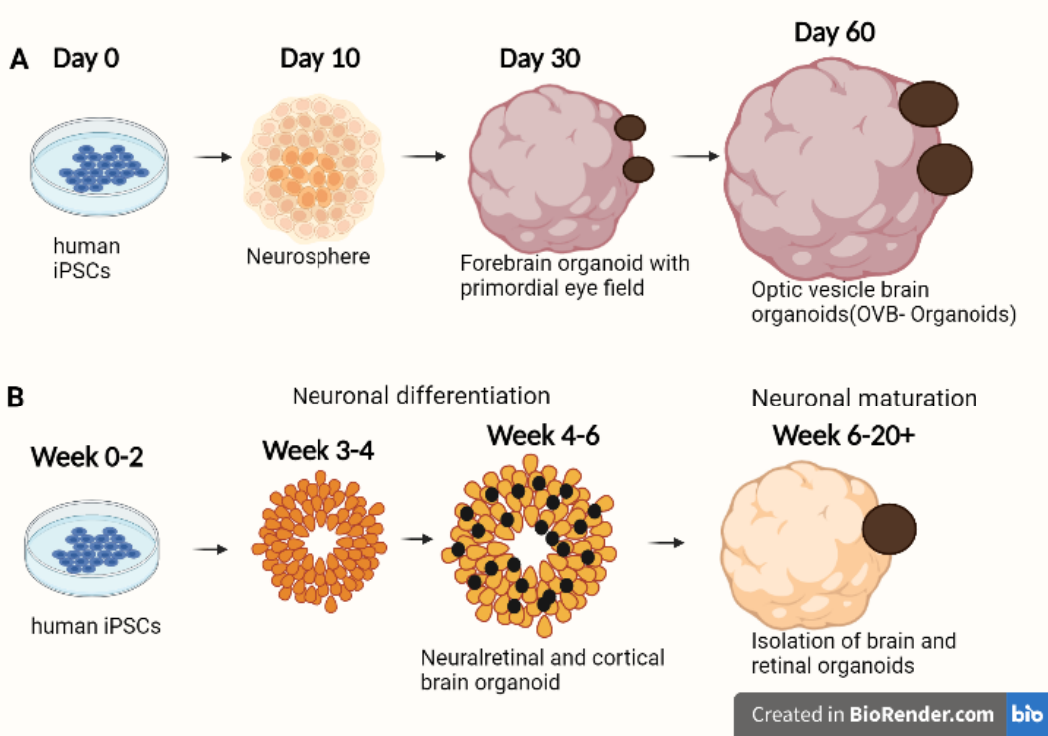
Figure 4. Differentiation protocols of optic vesicle-containing brain organoids for ocular applications. ( A ) Differentiation of iPSCs to brain organoids with optic vesicle regions (OVB), Elke et al., 2021 [83]. ( B ) Differentiation of iPSCs to complex organoid models created by the generation of both retinal and forebrain cortical organoids, Milan et al., 2022 [23]. These organoids can help to study brain – eye interactions during embryo development, model congenital retinal disorders, and generate patient-specific retinal cell types for personalized drug testing and transplantation therapies.